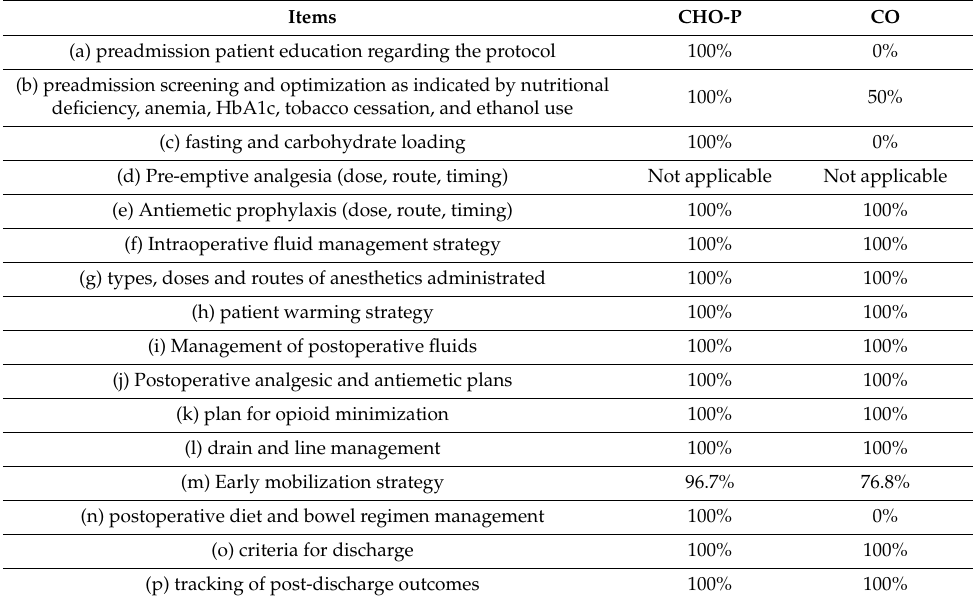
Table 2. Compliance study protocol between the intervention group (CHO-P) under Enhanced Recovery After Surgery and control group (CO) under conventional perioperative care.